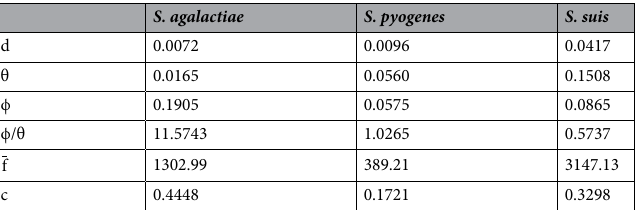
Table 1. Evolutionary and recombination parameters calculated by mcorr. Core genome alignment of each species was used as input in mcorr with 1000 bootstrapped replicates. Bootstrapping results are shown in Supplementary Table S3. d diversity brought into the population by recombination and clonal diversity, θ mutational divergence, ϕ recombinational divergence, ϕ/θ relative rate of recombination to mutation, f mean fragment size of a recombination event, c recombination